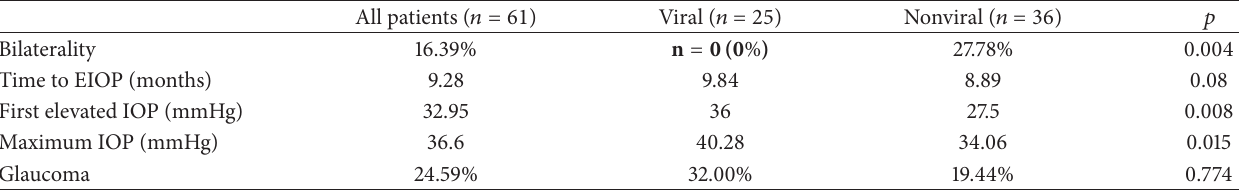
Table 3: Laterality, IOP, and